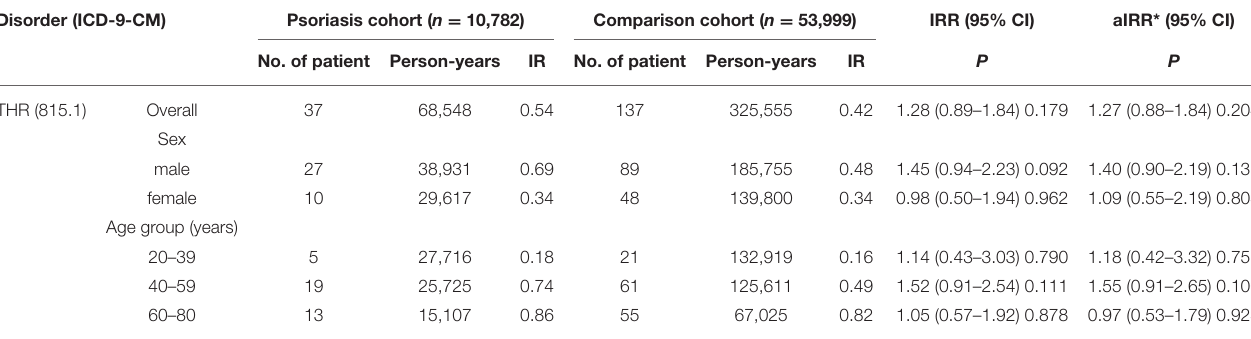
TABLE 3 | The incidence rate and incidence risk ratio of total hip replacement in the psoriasis cohort and comparison cohort ( N = 64,781). Disorder